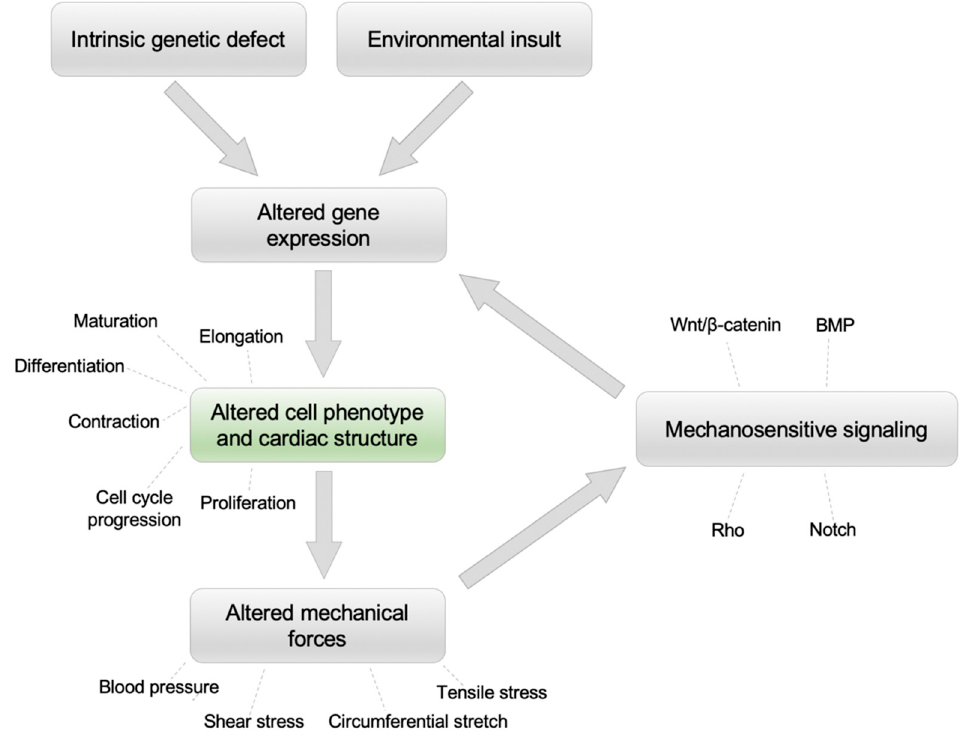
Figure 3. Schematic of how upstream factors (intrinsic genetic disturbances or environmental insult) can converge on downstream processes to cause hypoplastic left heart syndrome (HLHS).